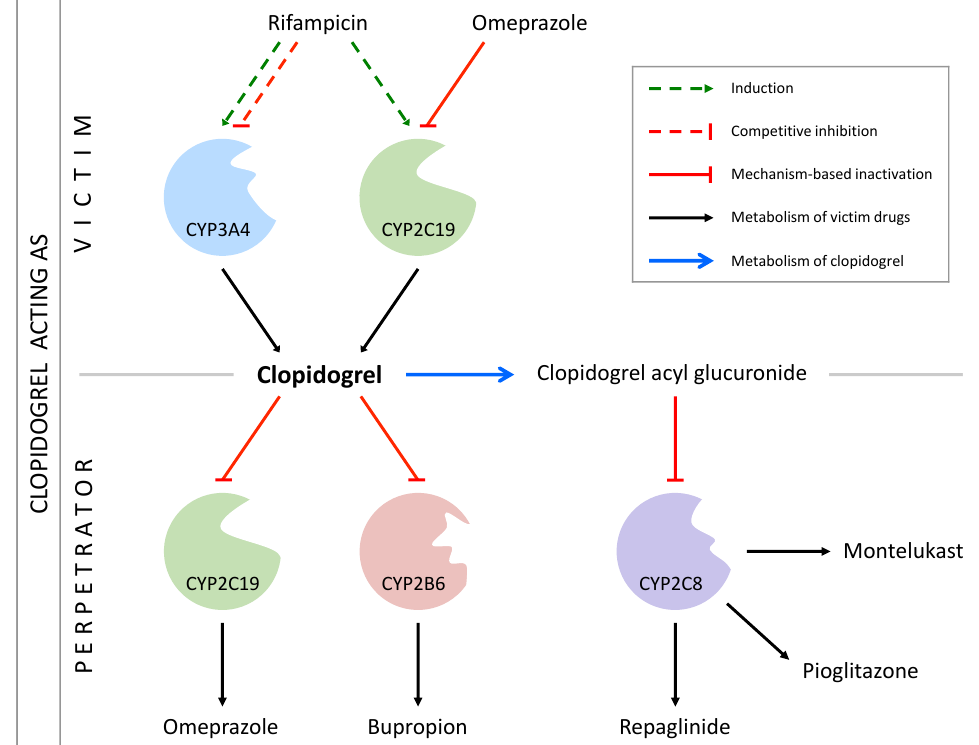
Figure 5. Schematic overview of the modeled drug–drug interaction network. For brevity, only the respective main interaction processes are shown. While clopidogrel acts as victim in the context of drug–drug interactions with omeprazole and rifampicin, it represents the perpetrator when administered concomitantly with bupropion and omeprazole. As stated by the United States Food and Drug Administration, in particular, clopidogrel acyl glucuronide acts as a perpetrator regarding CYP2C8 [28]. Montelukast, pioglitazone, and repaglinide were included in the drug–drug interaction network as CYP2C8 substrates. Table S11 of the Supplementary Materials contains a list of all implemented interaction processes per drug–drug interaction. CYP: cytochrome